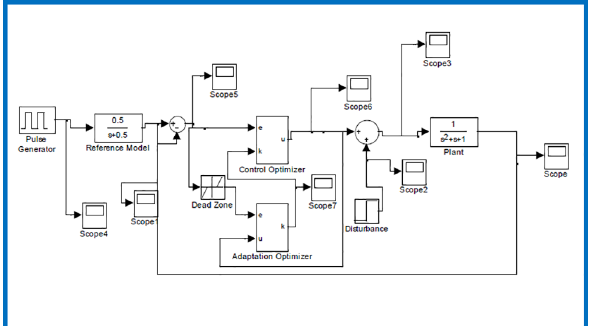
Fig 2. Simulink simulation model for the first